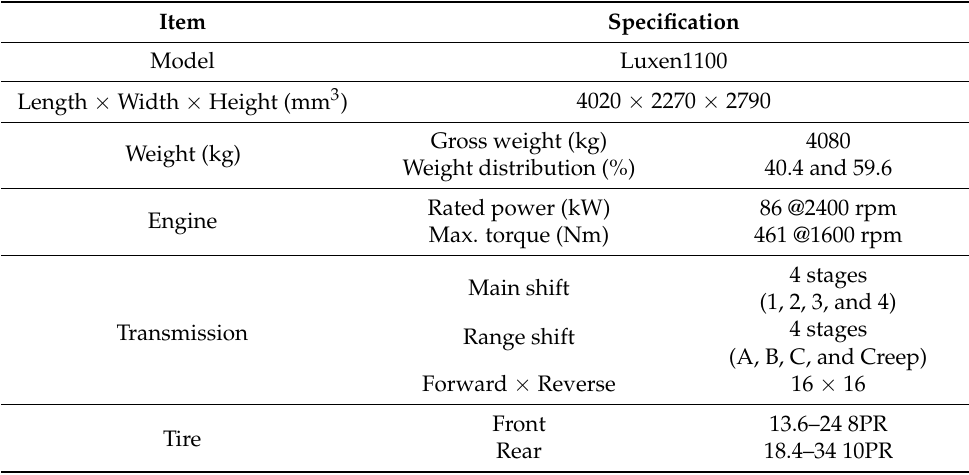
Table 1. Specifications of the 86 kW class agricultural tractor used in this study.